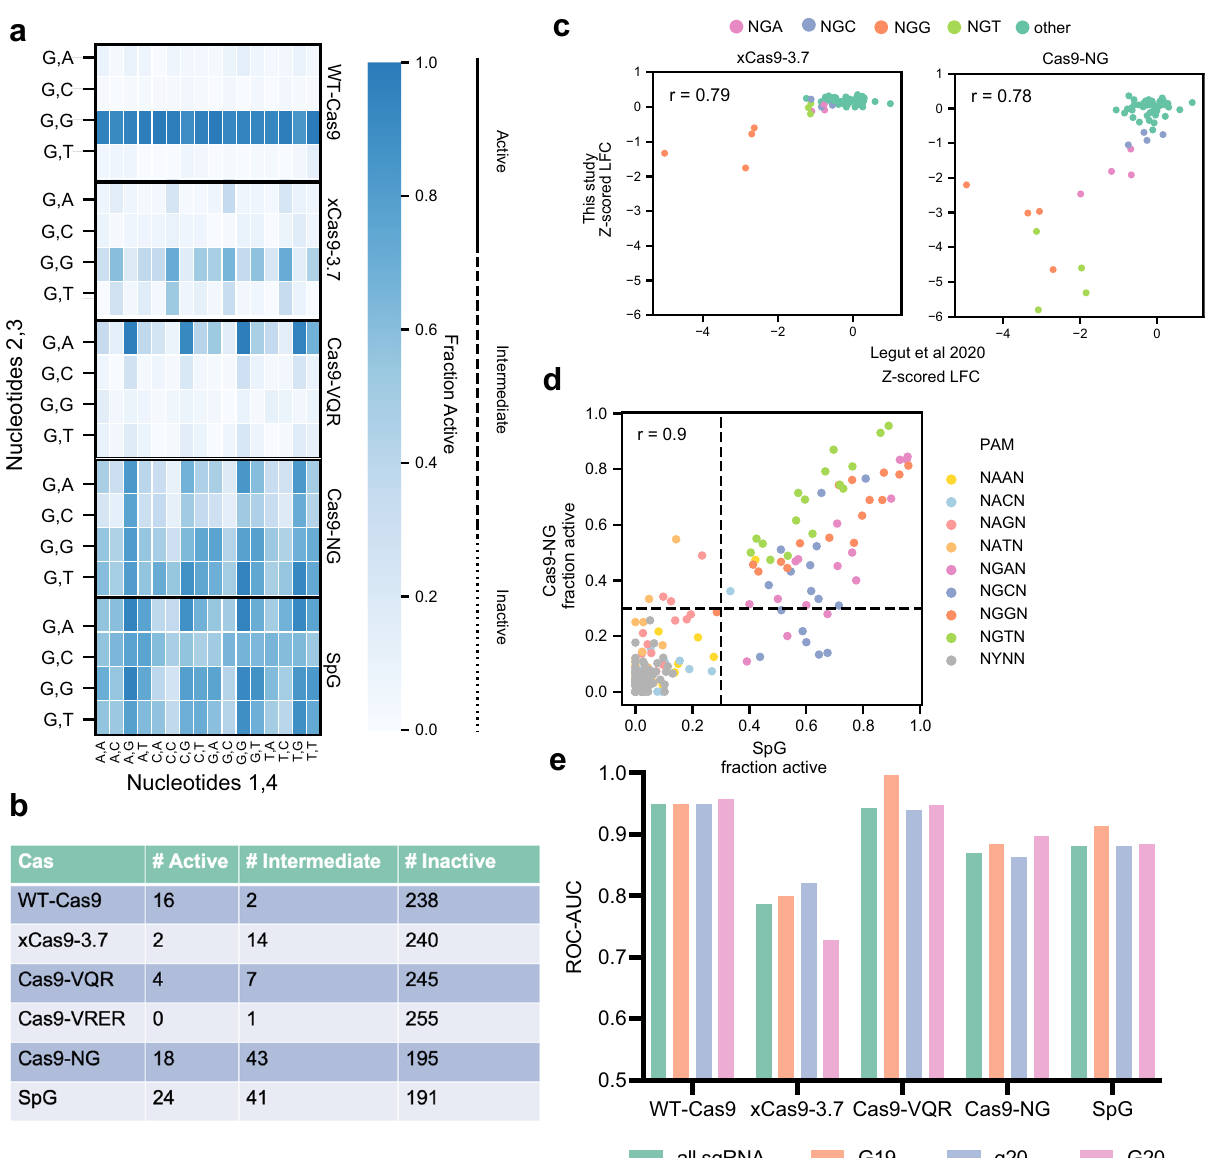
Fig. 3 Benchmarking PAM- fl exible variants. a Heatmap of fraction active values at all NGNN PAMs. Nucleotides 1 and 4 are along the x-axis, nucleotides 2 and 3 along the y-axis. b Table of fraction active values for each PAM- fl exible variant binned by activity bin. c Comparison of xCas9-3.7 (left) and Cas9-NG (right) to Legut et al. 2020. Points are colored by PAM. PAM-mapping z-scored LFC values on the y-axis refer to data in the present study. d Comparison of Cas9-NG and SpG fraction active values. Points are colored by PAM. Dashed lines at 0.3 indicate the cutoff for intermediate PAMs. e ROC-AUC values by 5 ′ -type for each PAM- fl exible variant. True positives are guides targeting essential genes, false positives are guides targeting nonessential genes. Only active PAMs are considered in this analysis. Source data are provided as a Source Data fi